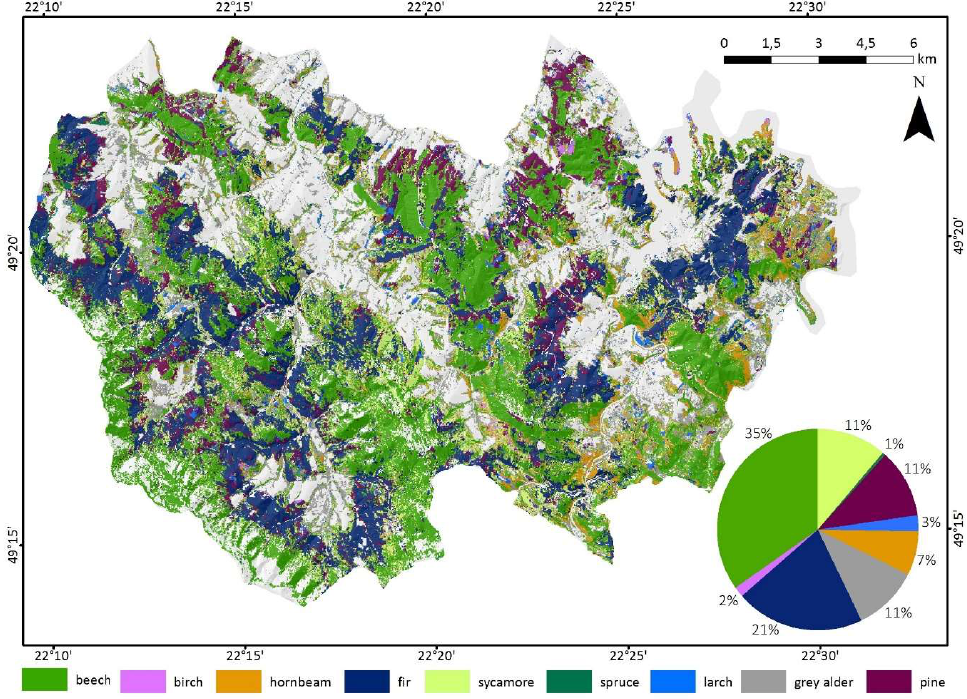
Figure 9. Forest tree species composition in the Baligród Forest District for the best-accuracy classification performed for Sentinel-2 data time series for five imageries from: 30-April/05-May/14- October/17-October/08-November.